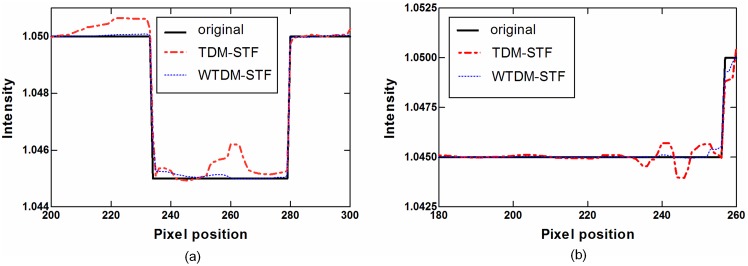
1D profiles of the images reconstructed by different algorithms using noise-free projections.(a) Horizontal profiles (240th row, 200th column to the 300th column); (b) Vertical profiles (258th column, 180th row to the 260th row).